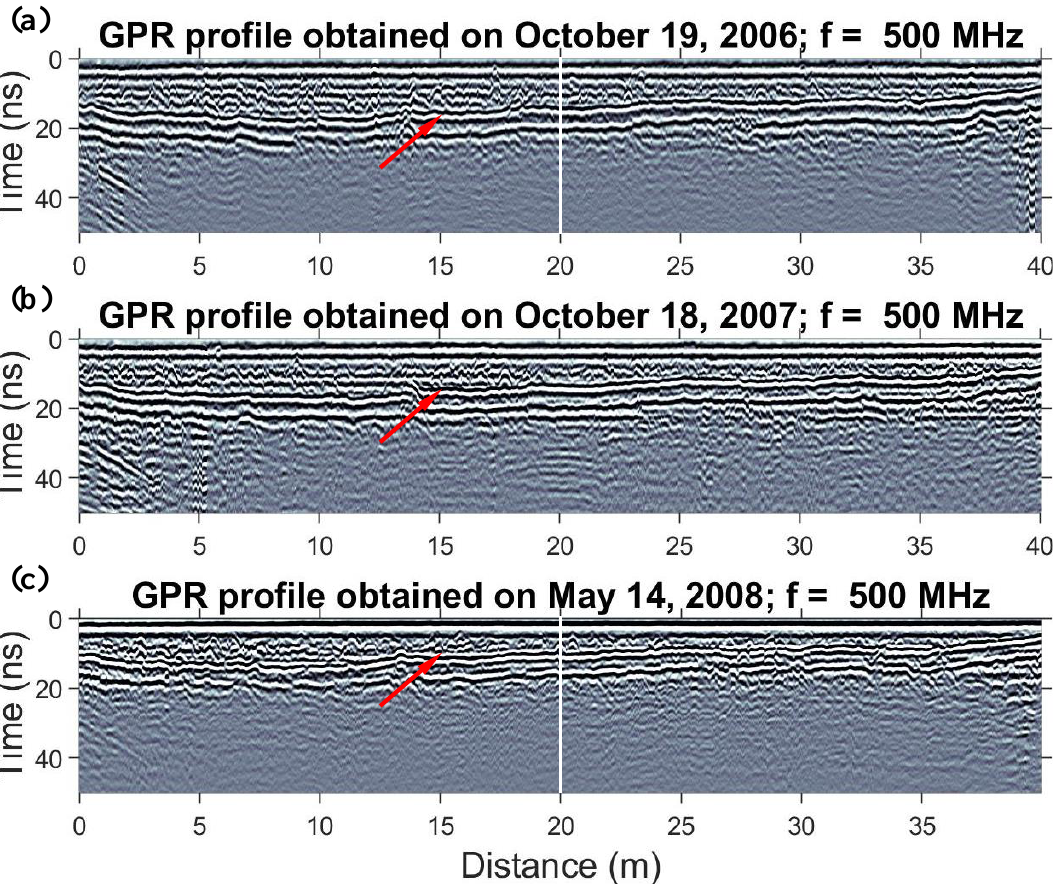
Figure 10. Three common-offset GPR profiles measured at the same location with a 500 MHz antenna at different periods. ( a ) October 2006; ( b ) October 2007; and ( c ) May 2008. The red arrow indicates the reflection coming from the concrete slab. The vertical white line indicates where the soil thickness is 0.5 m (Author’s own work).